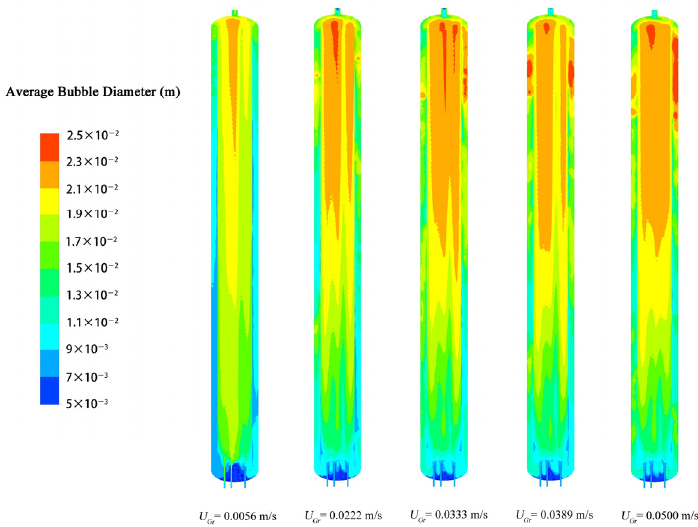
Figure 14. Average bubble diameter distribution with U Gr at a total column height of 15 m.